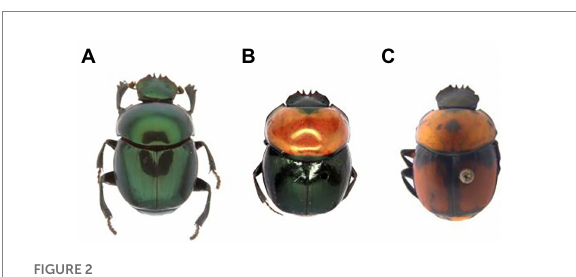
FIGURE 2 Canthon cyanellus subspecies sensu Halffter (1961). (A) C. c. cyanellus ; (B) C. c. violetae , and (C) C. c. sallei